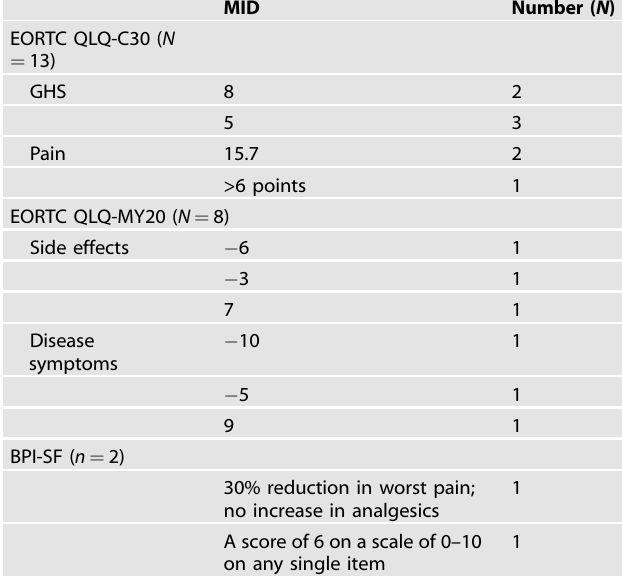
Table 5. Thresholds for minimal important difference